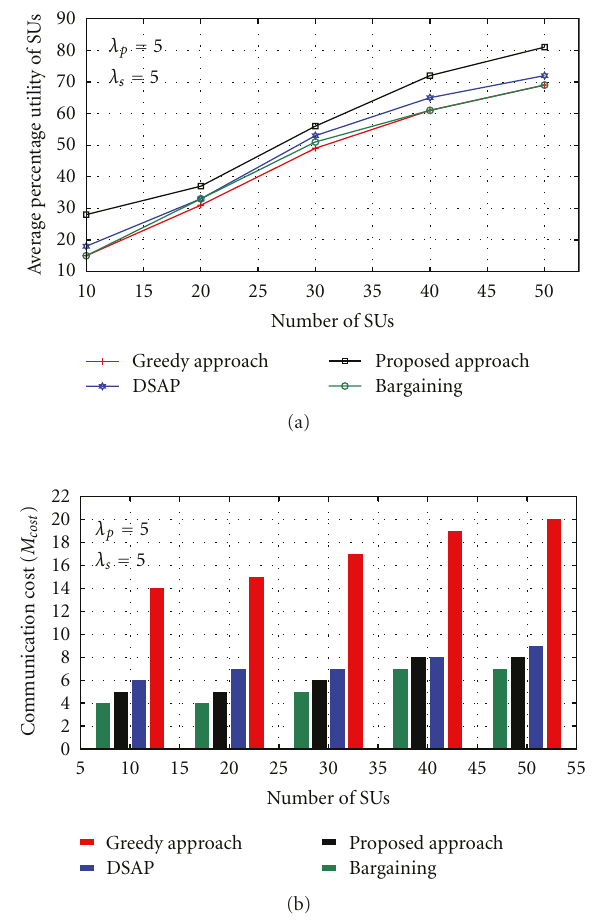
Figure 17: Comparison with greedy, local bargaining, and DSAP